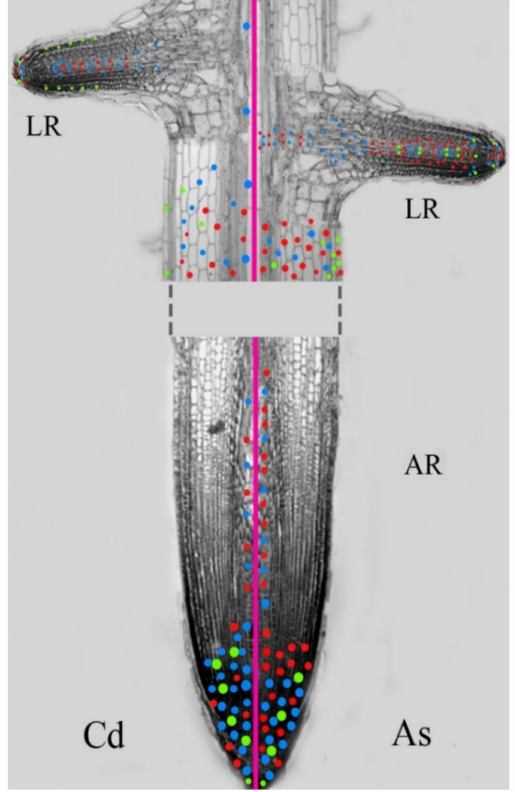
Figure 4. Model of indole-3-acetic acid (IAA) localization (blue dots), AUX1 expression (red dots) and nitric oxide (NO) signal (bright green dots) in an adventitious root (AR) and in lateral roots (LRs) of rice seedlings grown for 10 days in the presence of Cd or